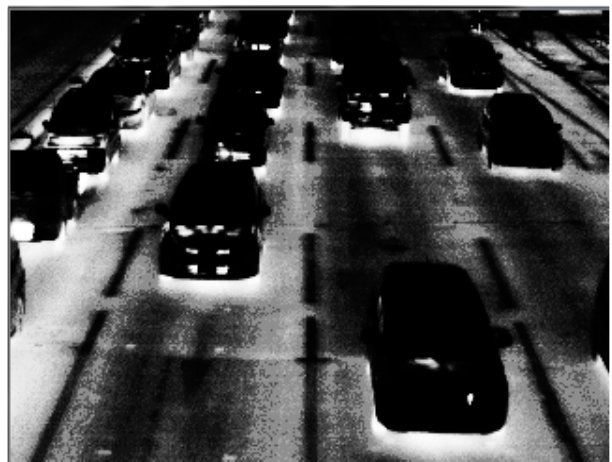
Figure 10. A transformed image